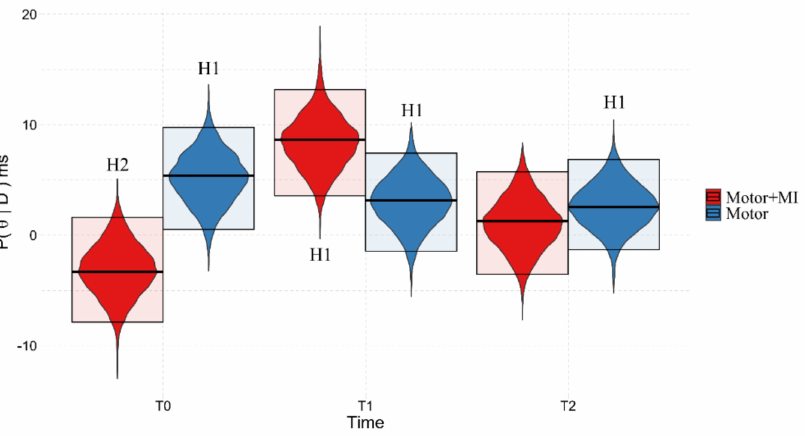
Figure 9. Graphical representation of the marginal posterior distributions (P( θ |D)) of the Group:Time interaction. Description as in Figure 4. H1 = Pr(x > 0) > 83.5%, meaning that the BSE is greater than zero, indicating a preserved body representation. H2 = Pr(x > 0) < 16.5%. T0 = baseline evaluation; T1 = post-training evaluation; T2 = follow-up evaluation. Motor + MI = Motor Treatment and Motor Imagery group. Motor = Motor Treatment only